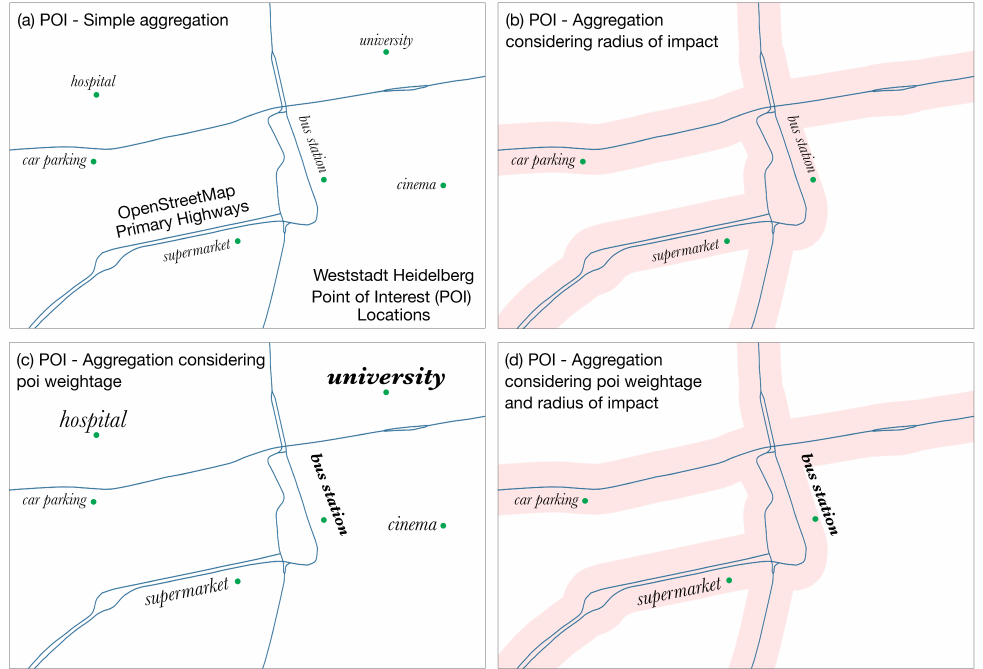
Figure 3. The figure shows four ways to aggregate land-use and land-cover POI data for a given tile. For ( a ), a simple counting of all POIs in an area of interest is performed. In ( b ) a pre-defined road buffer, per different highway type, is used to select only nearby POIs before counting. In ( c ) pre-defined weights, according to the importance of the infrastructure, are used while counting, and in ( d ) a pre-defined road buffer, per different highway type, in addition to weighting is used to select and prioritise only nearby POIs before